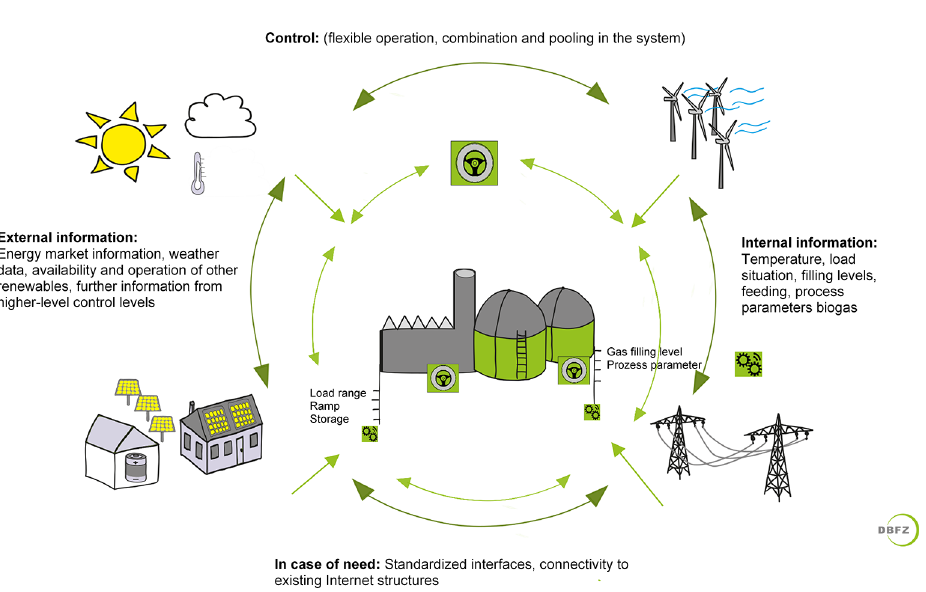
Fig. 4. – System elements and data flows for the flexibilization of bioenergy plants using modern information and communication technology